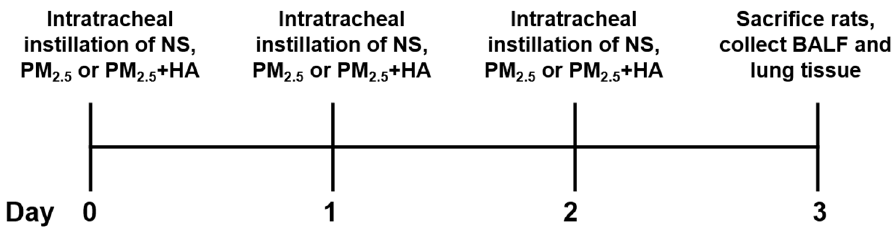
Figure 8. Timeline of animal experiments.